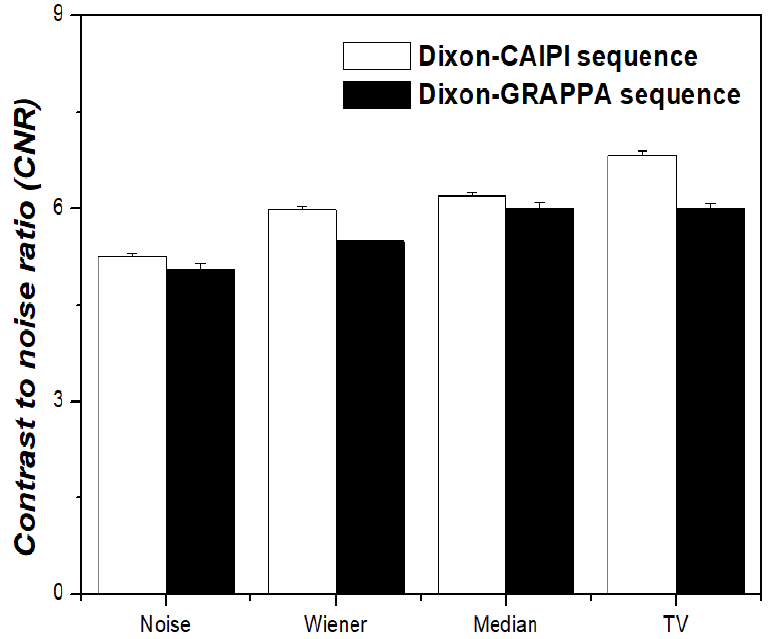
Figure 5. Contrast-to-noise ratio (CNR) according to noise-reduction techniques between MR- AC Dixon-CAIPI -based and MR-AC Dixon-GRAPPA -based PET images.